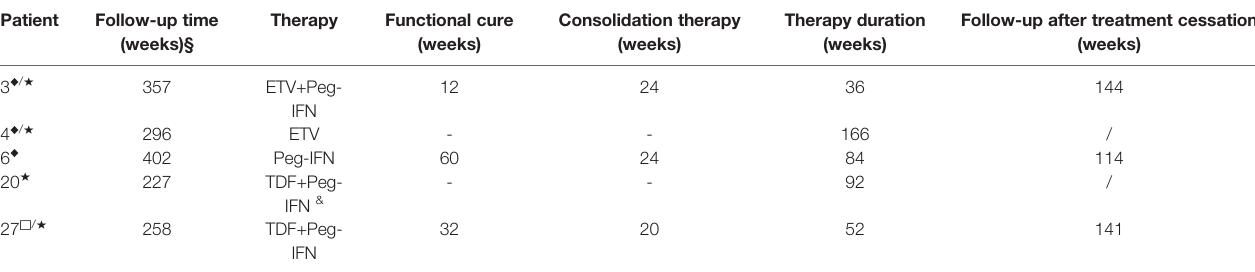
TABLE 3 | Therapeutic method and outcomes of 5 patients who were under dynamic observation initially, followed by